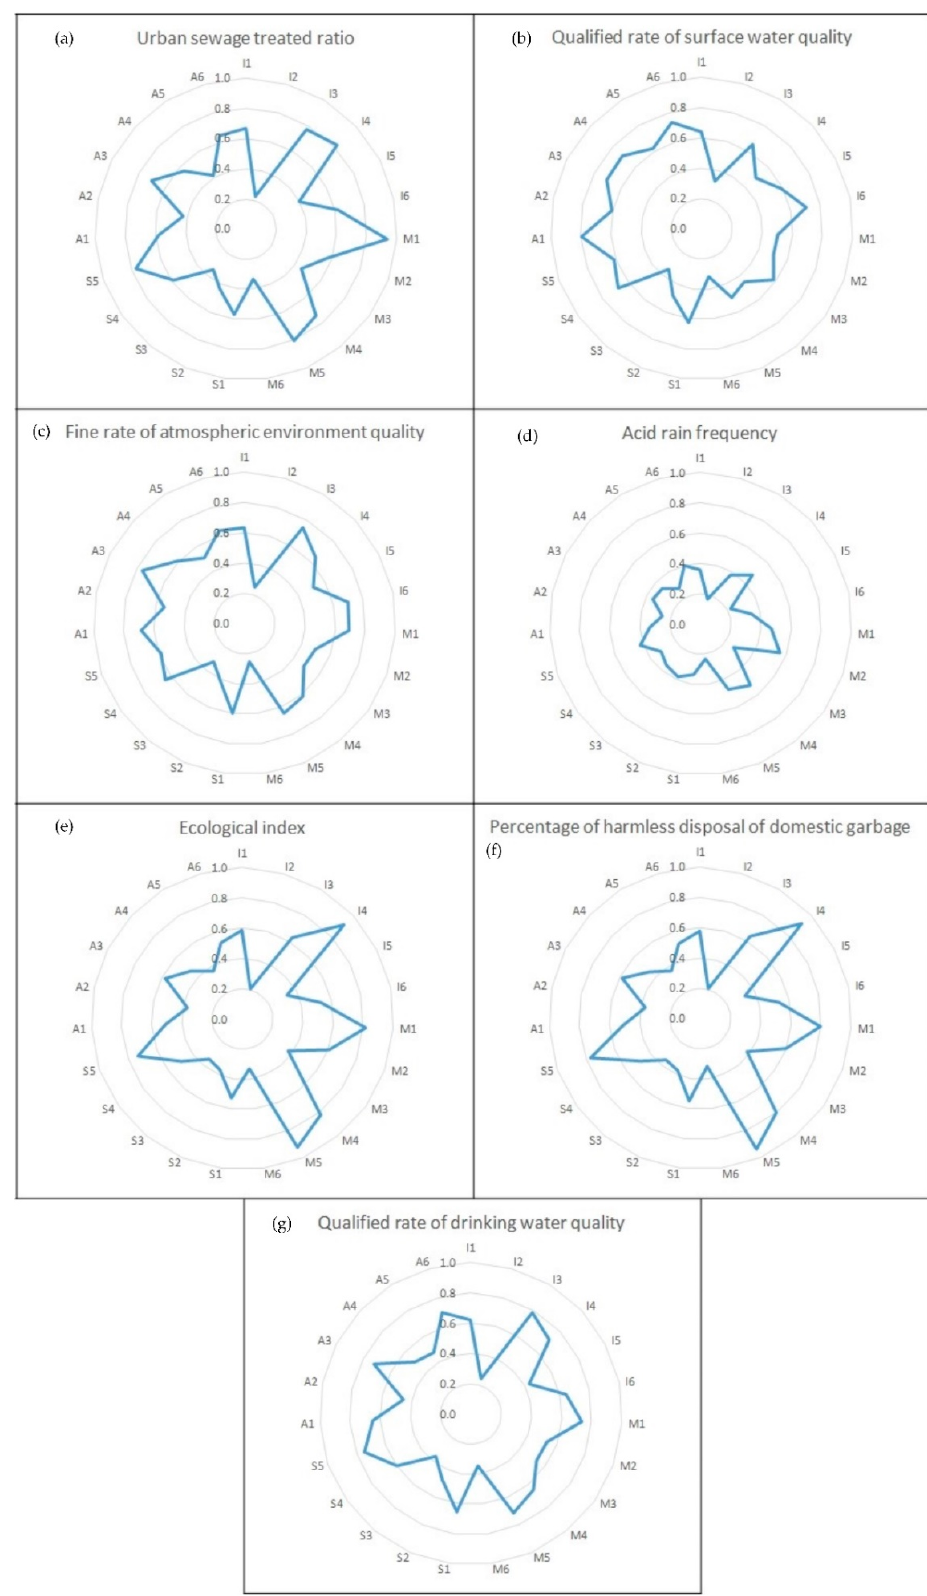
Figure 3. Contribution degree of QI attribute indices to ( a ) urban sewage treated ratio; ( b ) qualified rate of surface water quality; ( c ) fine rate of atmospheric environment quality; ( d ) acid rain frequency; ( e ) ecological index; ( f ) percentage of harmless disposal of domestic garbage; ( g ) qualified rate of drinking water quality in Zhejiang.